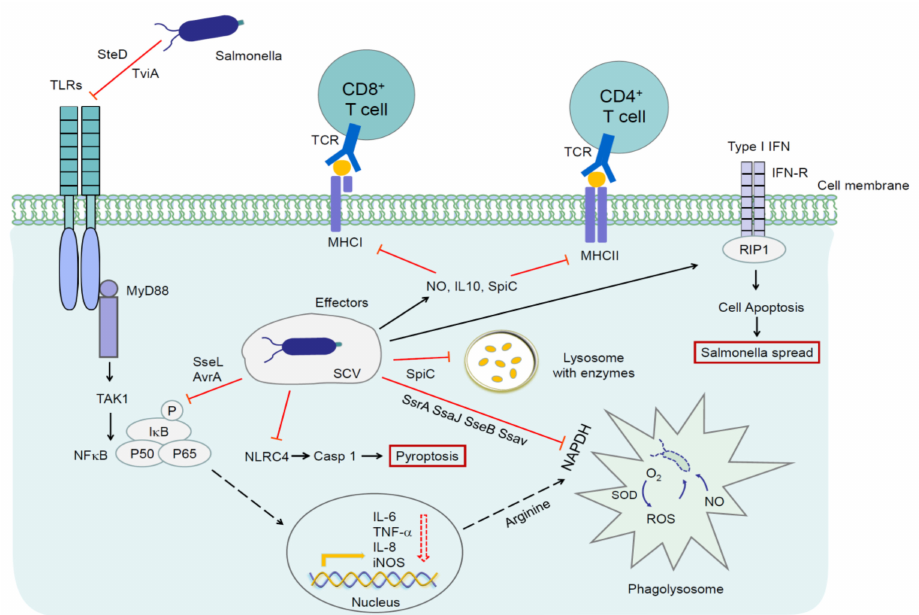
Figure 2. Mechanisms by which Salmonella escape host immune responses. SPI-2 e ff ector SpiC prevents DCs from presenting antigens to MHCs, and SifA blocks MHC II expression, resulting in an inadequate activation of naive T cells. SPI-2 e ff ector SteD with its chaperone SrcA is a key requirement for Salmonella which suppress T cell activation by forcing an inappropriate ubiquitination of MHC II. SseB, SsrA, SsaJ, Ssav are used for avoiding the oxidative burst. Salmonella also increases IL-10 and NO production and induces the expression of iNOS to inhibit the proliferation of T cells. Furthermore, when SPI2 is activated, the expression of flagellin in the intracellular environment is inhibited, preventing the NLRC4 from recognizing Salmonella . During the course of infection, Salmonella exploits the host type I interferon response to eliminate the macrophages through RIP-dependent cell death and promotes its own survival. TLR: Toll-like receptor; MyD88: Myeloid di ff erentiation primary response gene